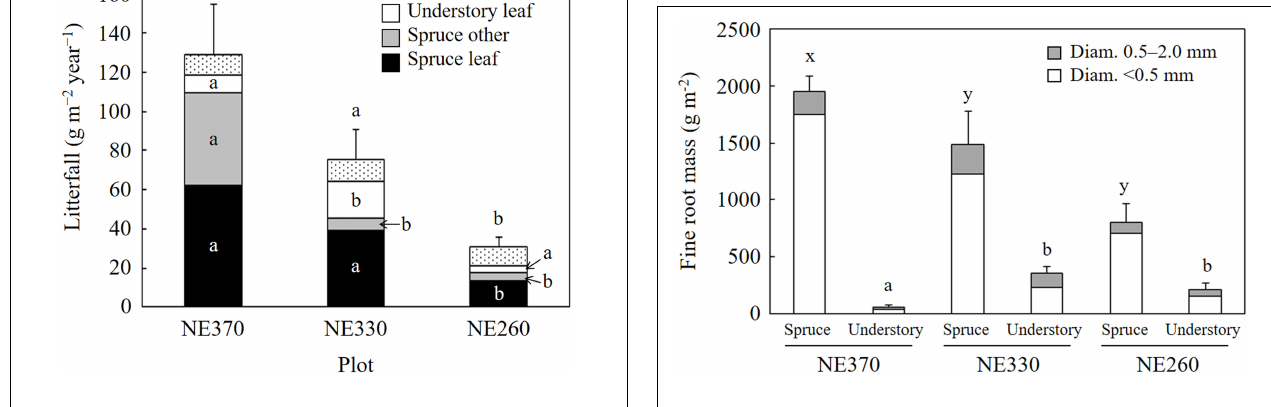
FIGURE 1 | Litterfall production rates in NE360, NE330, and NE260 plots. Black, gray, white, and dotted columns represent data on leaves of black spruce, other organs of black spruce, leaves of understory plants and others, respectively. Data shown are mean + SE ( N = 7–8). Different alphabetical letters indicate significant difference between the plots within each organ (Tukey–Kramer HSD test).